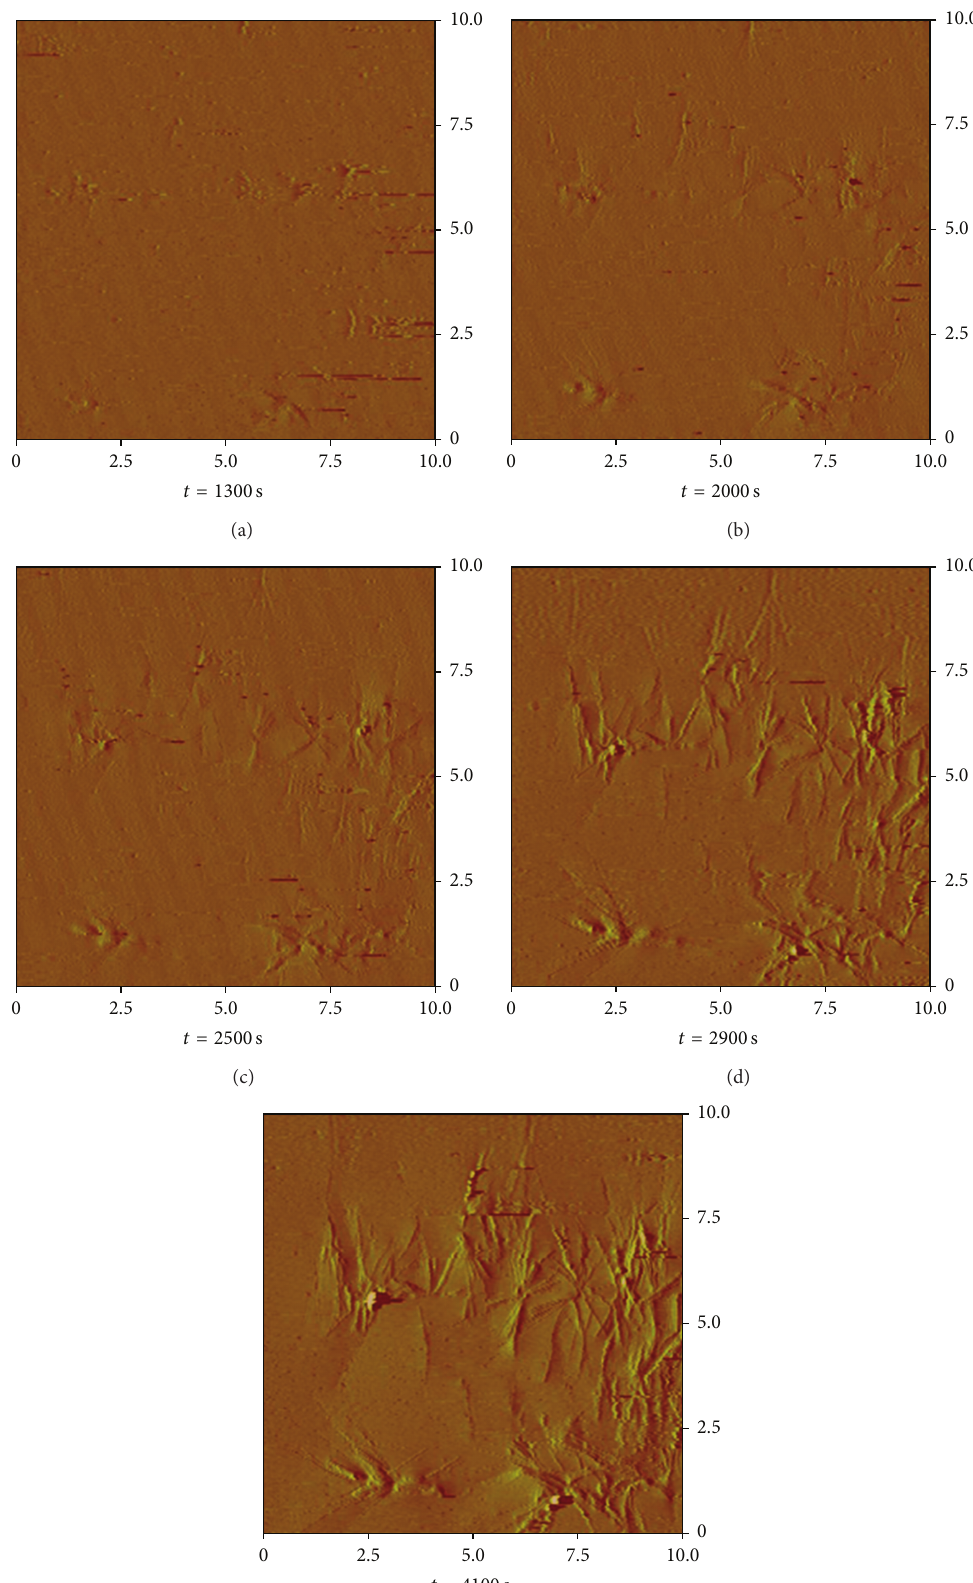
Figure 10: AFM amplitude images on a square area with sides of 10 𝜇 m ( 𝑇 𝑐 = 50 ∘